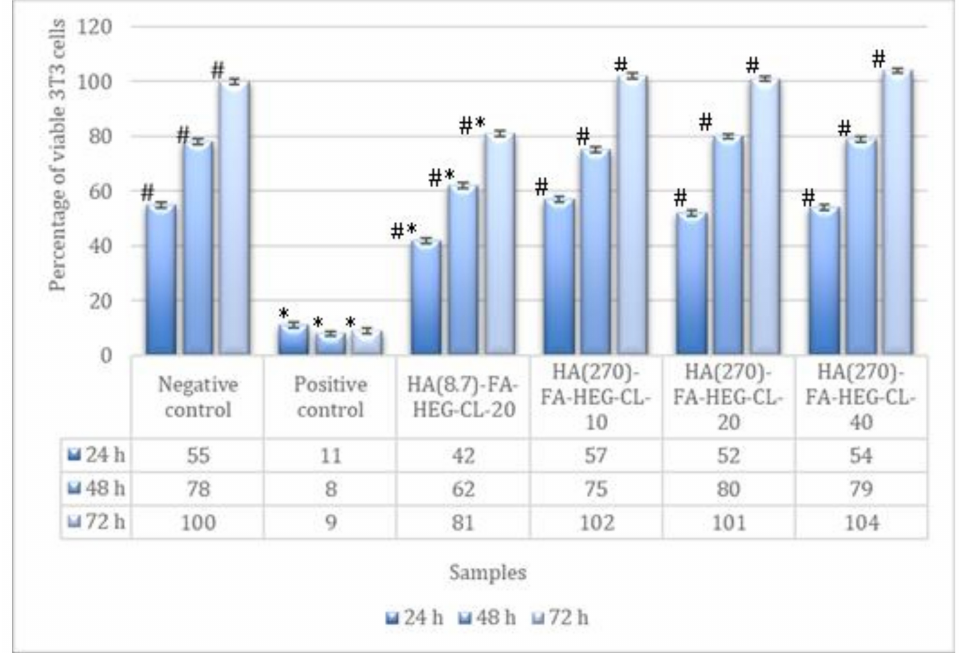
Figure 11. The percentage of viable NIH3T3 fibroblasts evaluated by the neutral red assay after 24, 48, and 72 h of contact with the tested samples (samples concentration = 0.6 mg/cm 2 ). Data are means ± SD of one experiment run in triplicate. * Value is statistically different in comparison to negative control LDPE, p < 0.05. # Values are statistically different in comparison to positive control PVC-org. Sn, p <